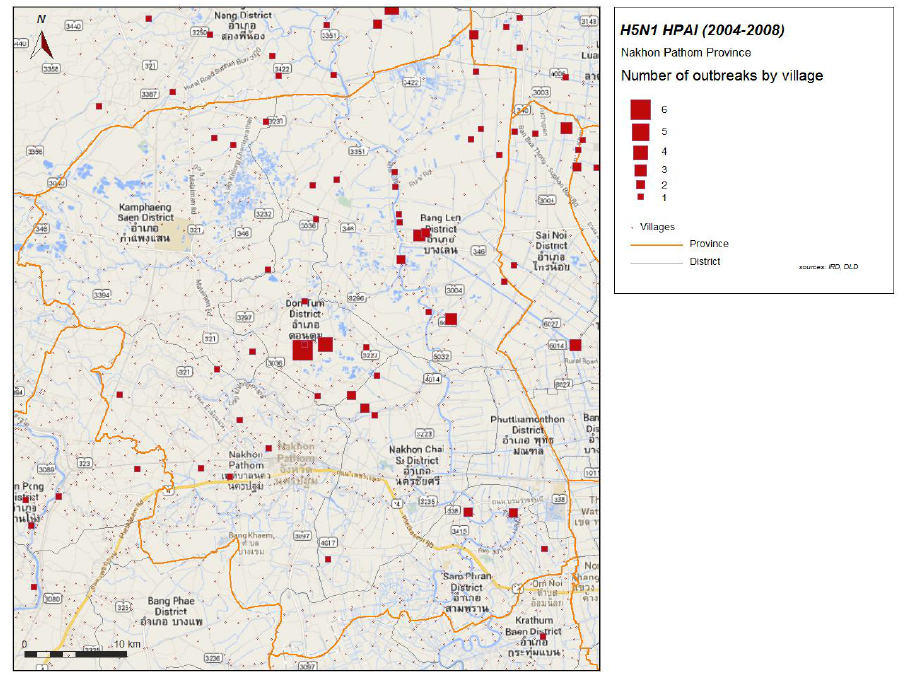
Figure 2. H5N1 HPAI outbreaks by village, 2004–2008 in Nakhon Pathom